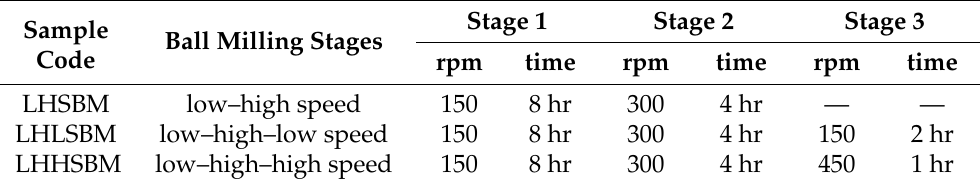
Table 1. Sample justification and ball-milling